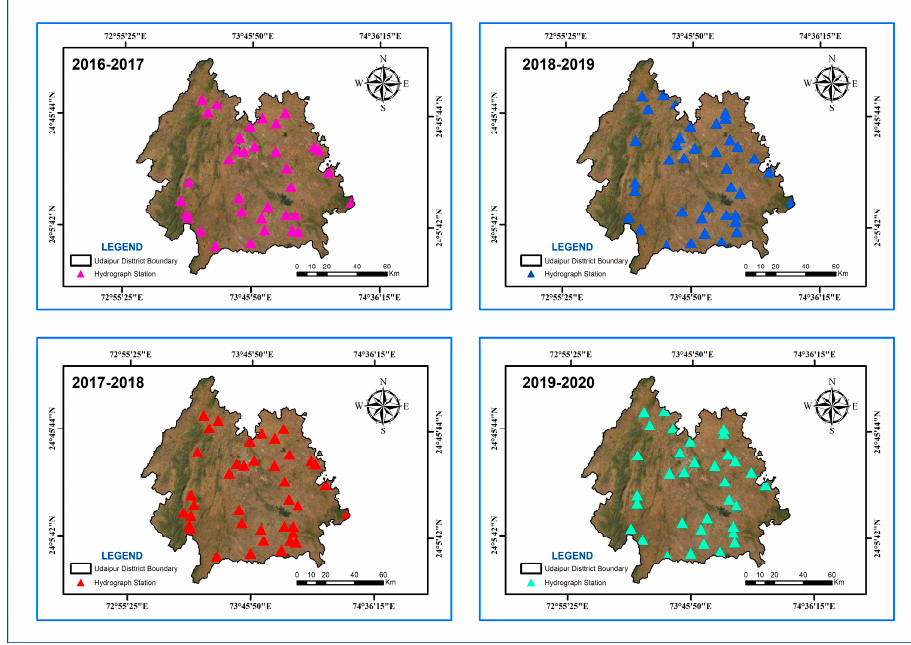
Figure 7. The distribution of hydrograph stations in the Udaipur district.